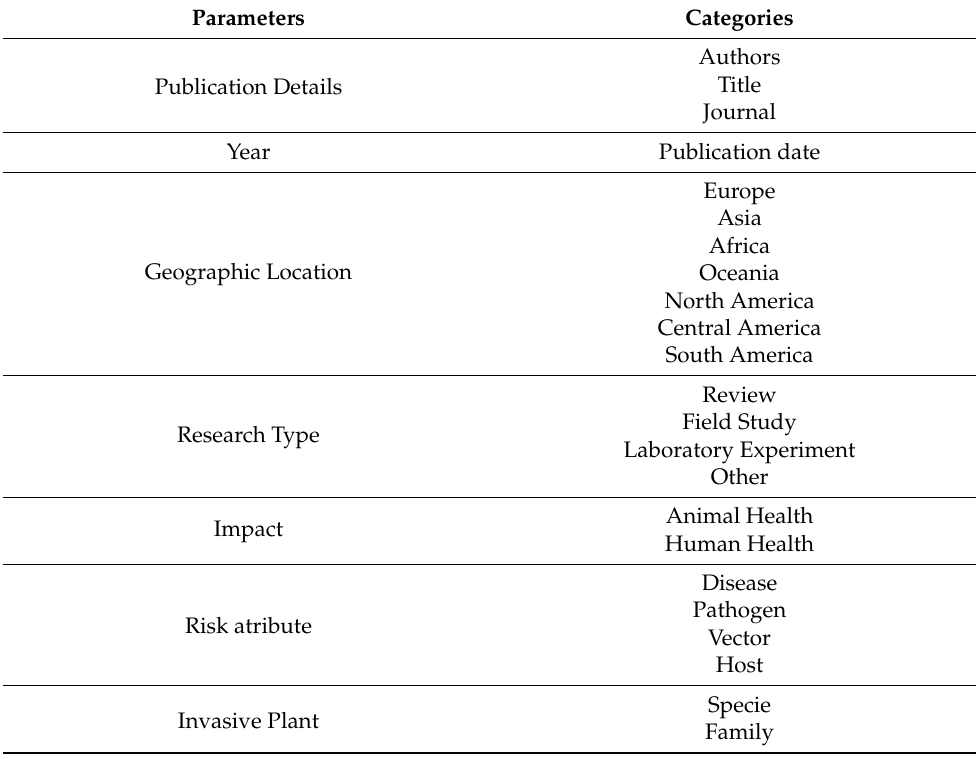
Table 3. Characterization of data collected and selected for qualitative